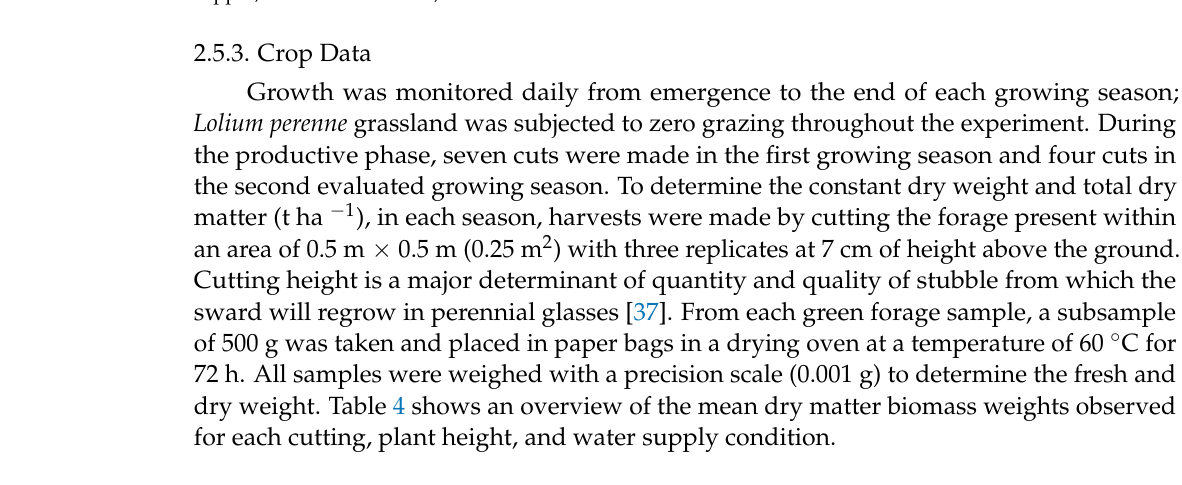
Table 4. Observed dry-matter production, plant height, irrigation, and days after planting (DAP) for the different cuttings of ryegrass ( Lolium perenne L.) in the two cropping seasons